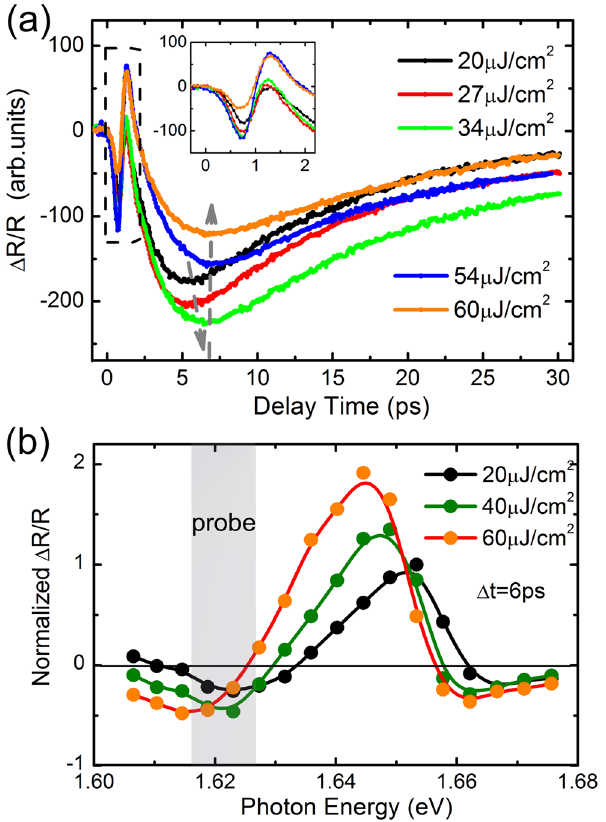
Figure 4. ( a ) Transient reflectivity measured at different pump fluences with the on-resonant pump (1.653 eV) at excitons and on-resonant probe (1.622 eV) at trions. The inset shows the zoom-in Δ R / R within 2 ps. ( b ) The corresponding differential reflectivity spectra at 6 ps with increasing pump